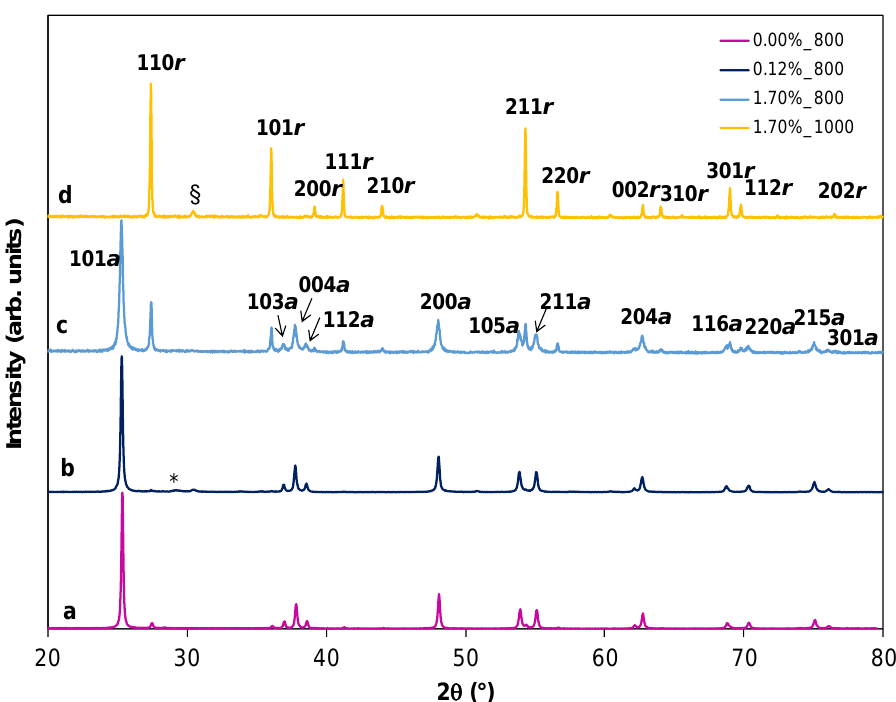
Figure 10. (a) Normalized and indexed XRD patterns of 0.00%_800 (a), 0.12%_800 (b), 1.70%_800 (c) and 1.70%_1000 (d). HSs. a indicates anatase and r rutile phase, respectively. The peak of the Si holder and SiO 2 (contamination of agate mortar after milling: crystoballite quartz) are labeled * and §, respectively .